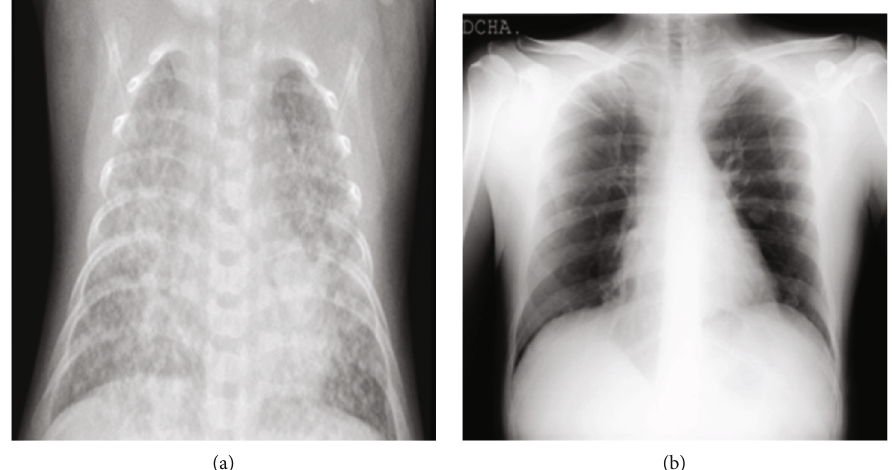
Figure 1: The sample X-ray images of (a) a viral pneumonia patient and (b) a COVID-19 patient as collected from the Kaggle database